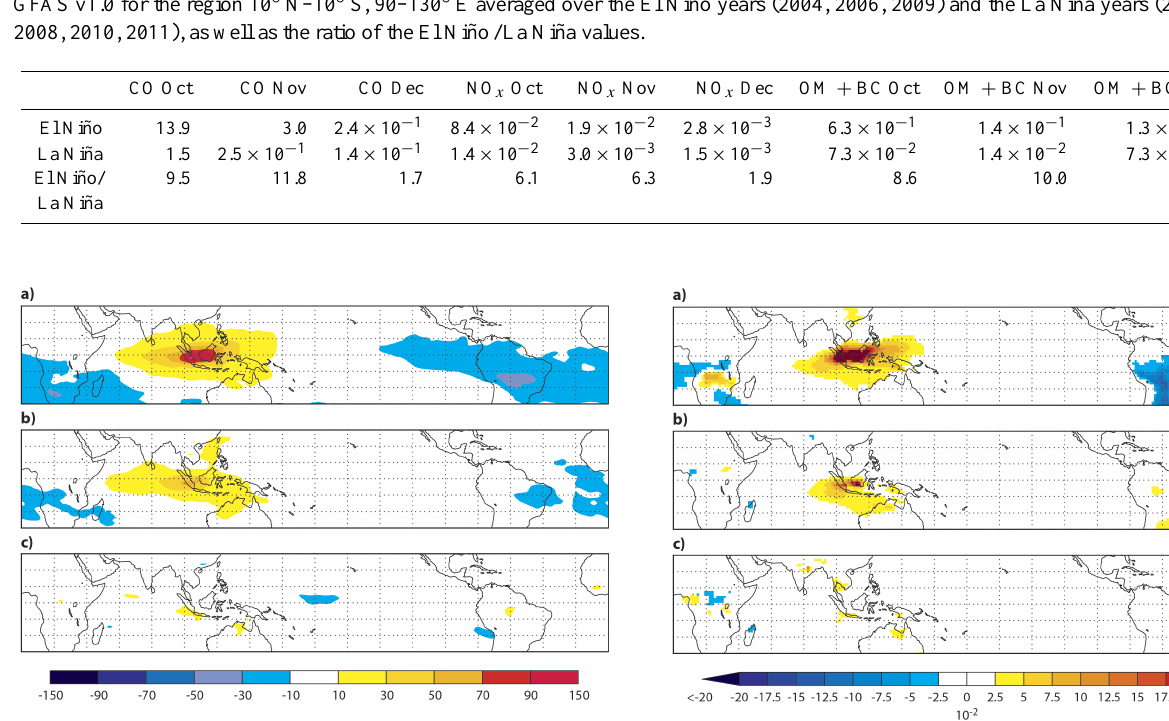
Figure 8. The same as Fig. 5 but for smoke AOD (BC + OM). AOD is